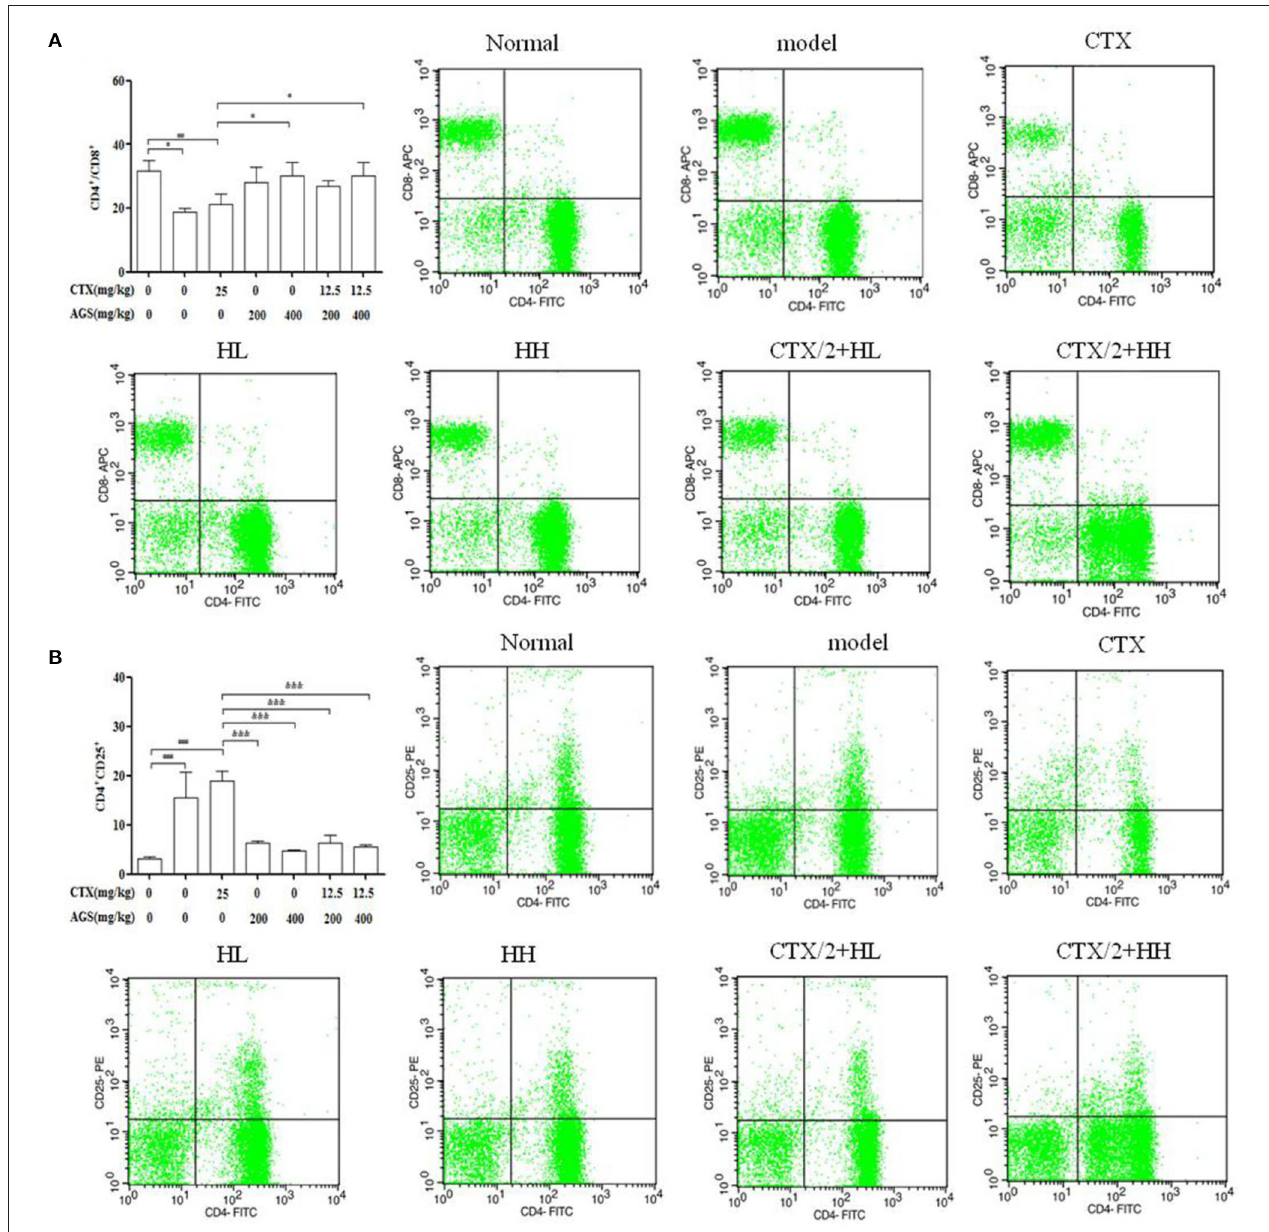
FIGURE 9 | Effects of AGS-H synergistic CTX/2 on lymphocyte subsets in S180 tumor-bearing mice ( n = 8). (A) CD4 + /CD8 + . (B) CD4 + CD25 + . Values are presented as mean ± SD. vs. normal group, # P < 0.05, ### P < 0.001; vs. model group, * P < 0.05, ** P < 0.01, *** P < 0.001; vs. CTX group, & P < 0.05, && P < 0.01, &&& P <